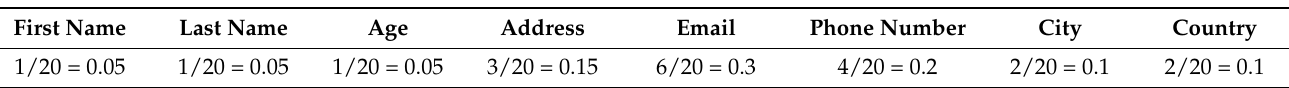
Table 6. Field’s